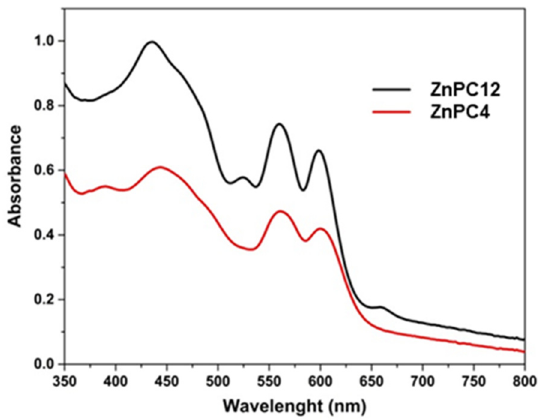
Figure 5. Adsorption spectra of sensitized photoanodes with ZnPC12 and ZnPC4